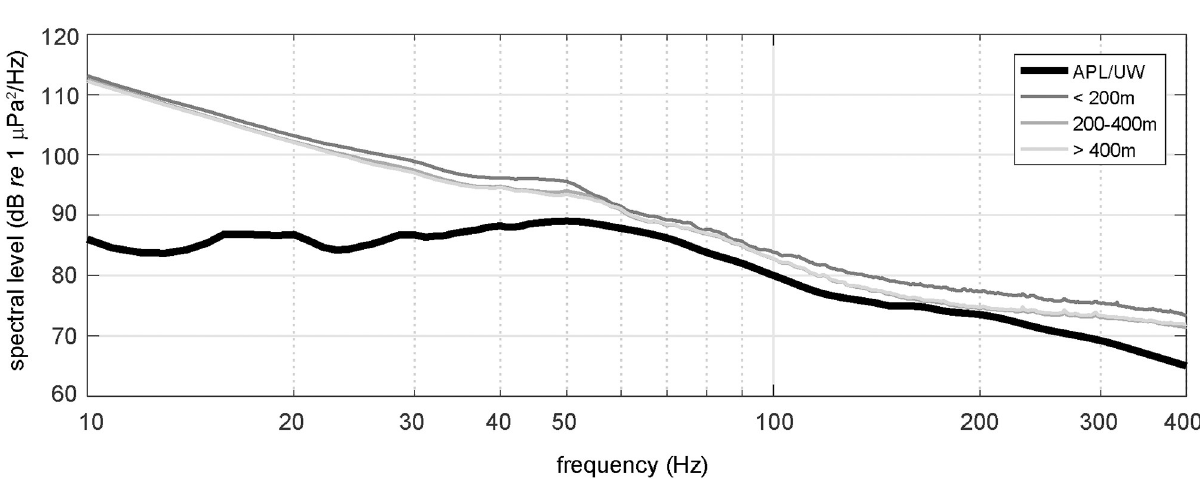
Fig 10. A comparison of median (50 th percentile) glider and fixed station spectral levels. Glider measurements from 3 depth intervals during the 2012 mission plotted against median spectra from a fixed, seafloor hydrophone system recorded from 1994–2007 near the same area in the northeast Pacific [18]. Values for APL/UW spectra taken from Andrew et al .’s, Fig 4 System h .